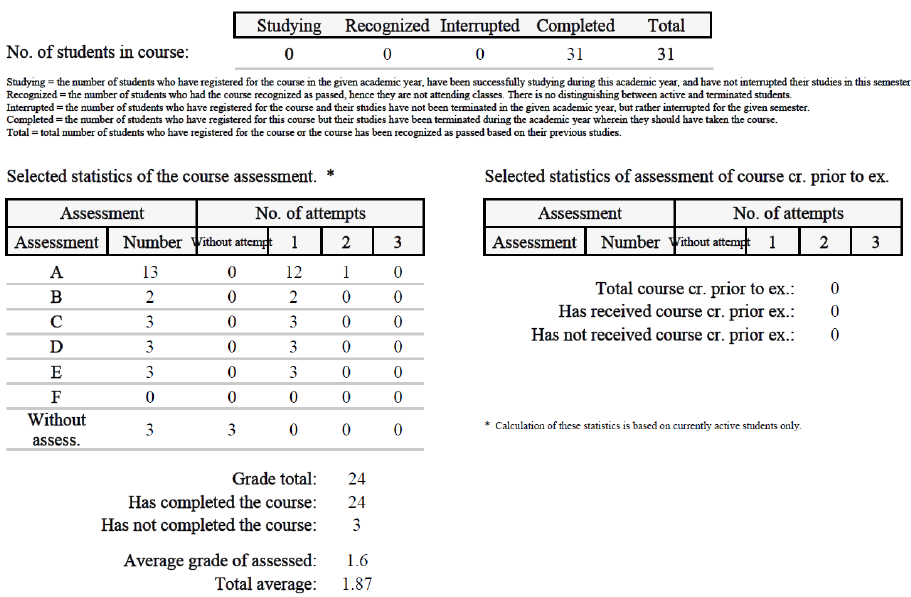
Figure 16. Results of all students during the academic year